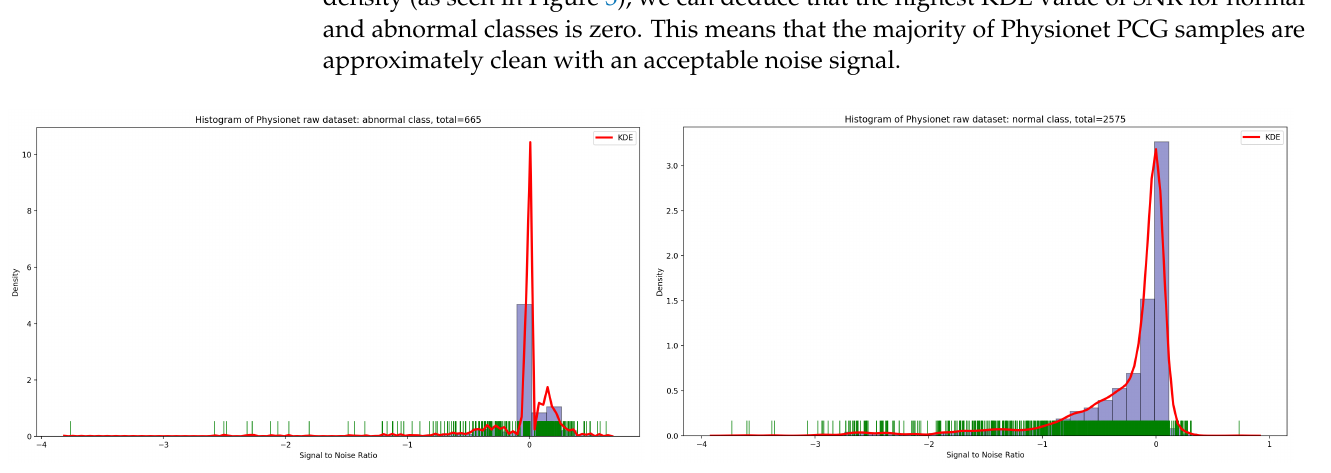
Figure 3. Signal-to-noise ratio in function of density related to normal and abnormal